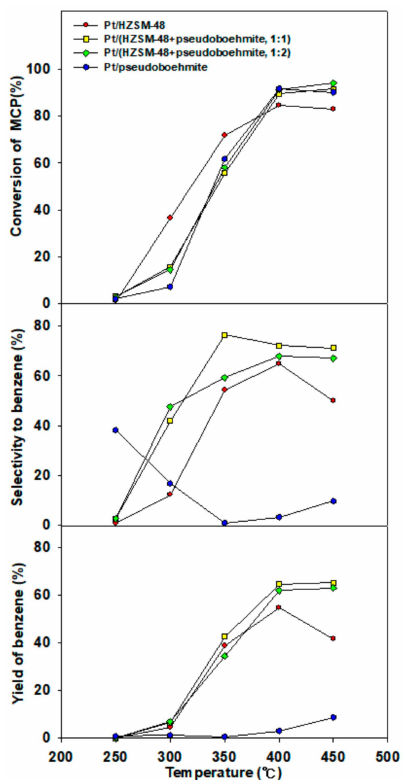
Figure 9. E ff ect of reaction temperature on conversion of methylcyclopentane (MCP), selectivity to benzene and yield of benzene over various catalysts (reaction condition: H 2 / MCP (mol / mol) 10, pressure 1 atm, weight hourly space velocity (WHSV) 0.3 h − 1 , and time-on-stream (T-O-S) 3